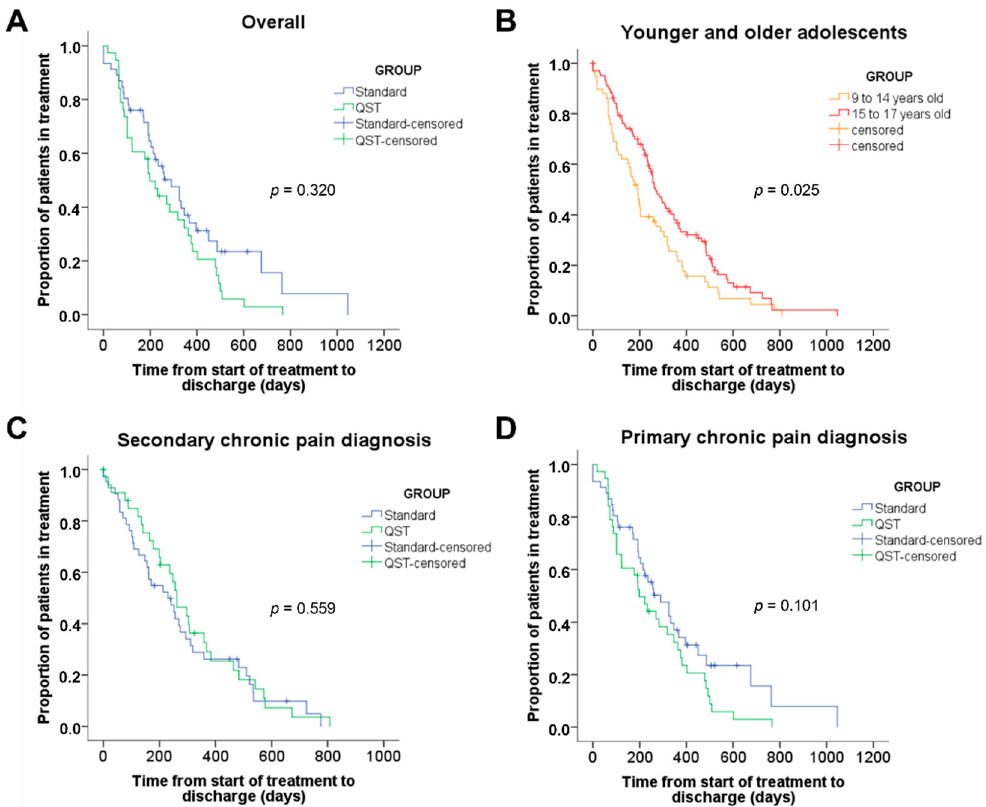
Figure 5. Kaplan–Meier plots of the duration of treatment of patients at the clinic expressed in days. Patients who left the clinic due to other reasons than discharge were censored. Such reasons may include transfer to another specialty (e.g., surgery, psychiatry), loss of follow-up, or transfer to adult treatment when patients reached 18 years old. ( A ) Overall comparison of patients with standard assessment and QST/CPM assessment (n.s.); ( B ) Comparison of younger patients (9–14 years old) and older patients (15–17 years old), ( p = 0.025); ( C ) Comparison of patients with standard assessment and QST/CPM among patients with primary pain diagnosis (n.s.); ( D ) Secondary chronic pain diagnosis (n.s.). Using a Bonferroni correction for multiple comparisons (significance level of p = 0.125), none of the results were significant. However, in panel B, there appears to be a trend for younger patients to complete treatment more rapidly than older patients.